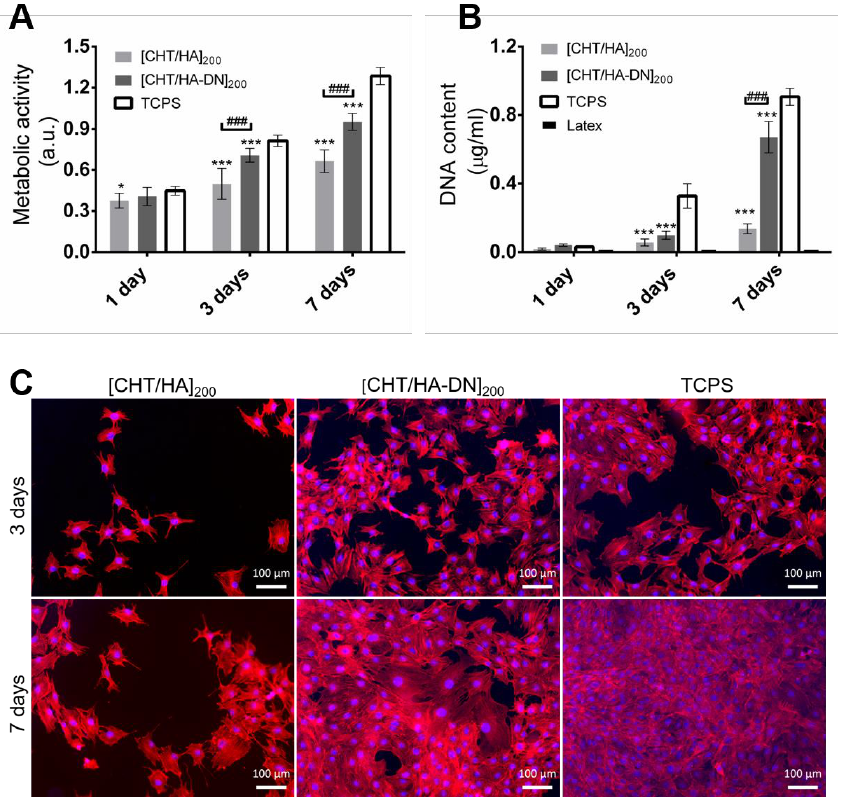
Figure 7. In vitro cell studies. ( A ) Metabolic activity of MC3T3- E1 cells seeded on the membranes (Alamar Blue assay). Significant differences were found between membranes and TCPS conditions (for * p < 0.05; *** p < 0.001) and between the two kind of systems (### p < 0.001); ( B ) DNA content of MC3T3- E1 seeded above the membranes (PicoGreen Kit). Significant differences were found between membranes and tissue culture polystyrene surface (TCPS) conditions (*** p < 0.001) and between the two kind of systems (### p < 0.001). ( C ) Fluorescence images of MC3T3- E1 cells stained with phalloidin (red) and 4',6-diamidino-2-phenylindole (DAPI) (blue), at three and seven days of culture on the[CHT/HA] 200 and [CHT/HA-DN] 200 membranes and the TCPS (positive control). a.u.: Arbitrary units.